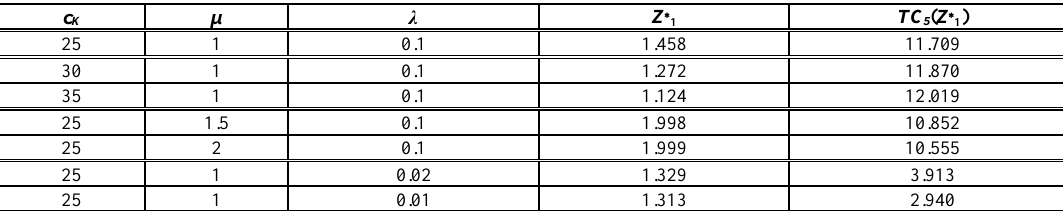
Table 5. Optimal Z ∗ 1 and TC 5 ( Z ∗ 1 ) of Model 5 for K =25, 30, 35, 𝜇 = 1, 1.5, 2 , and λ = 0.1, 0.02, 0.01 when c K